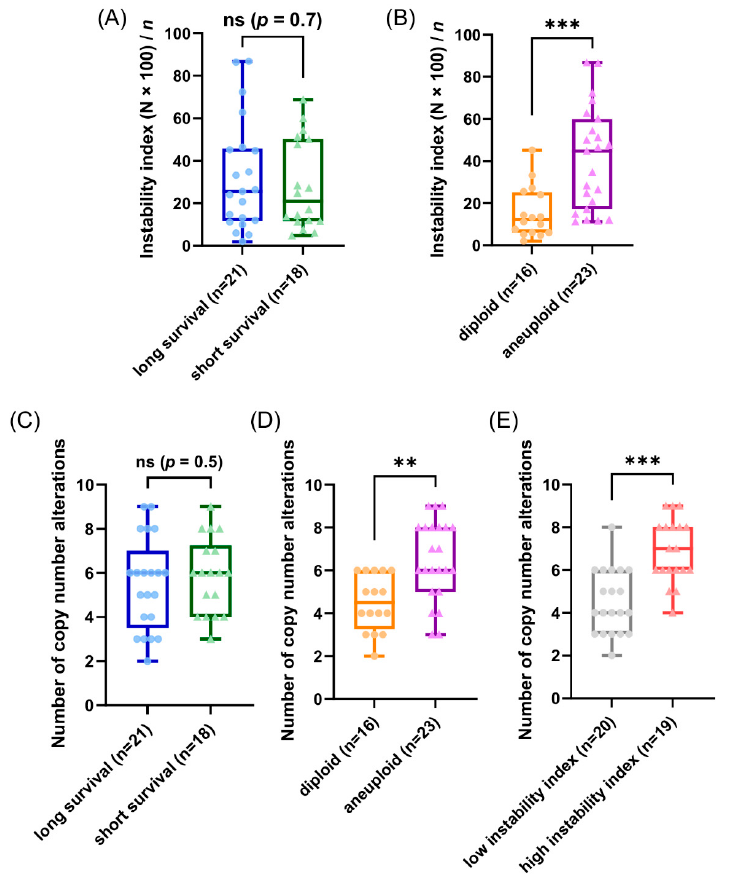
Figure 5. Results of the miFISH analysis presenting instability indices, calculated as described in Section 2, and frequencies of CNAs per tumor sample for different subgroups. ( A , B ) Instability indices including minimum, maximum, median and outliners are presented as a boxplot for each subgroup: ( A ) long and short survival and ( B ) diploid versus aneuploid tumors. Note the significant difference between diploid versus aneuploid tumors ( p = 0.0006). ( C – E ) Frequency of CNAs per tumor sample including minimum, maximum, median and outliners are presented as a boxplot for each subgroup: ( C ) long and short survival , ( D ) diploid versus aneuploid tumors and ( E ) tumors with low versus high instability index. Note the significant difference between diploid versus aneuploid tumors ( p = 0.0012) and between tumors with low versus high instability index ( p ≤ 0.0001); ** p ≤ 0.01; *** p ≤ 0.001. (Table S16) and in the number of CNAs between the groups: diploid tumors had on aver- age 4.5 CNAs, compared to 6.5 in the aneuploid tumors ( p = 0.0012, see Figure 5D and